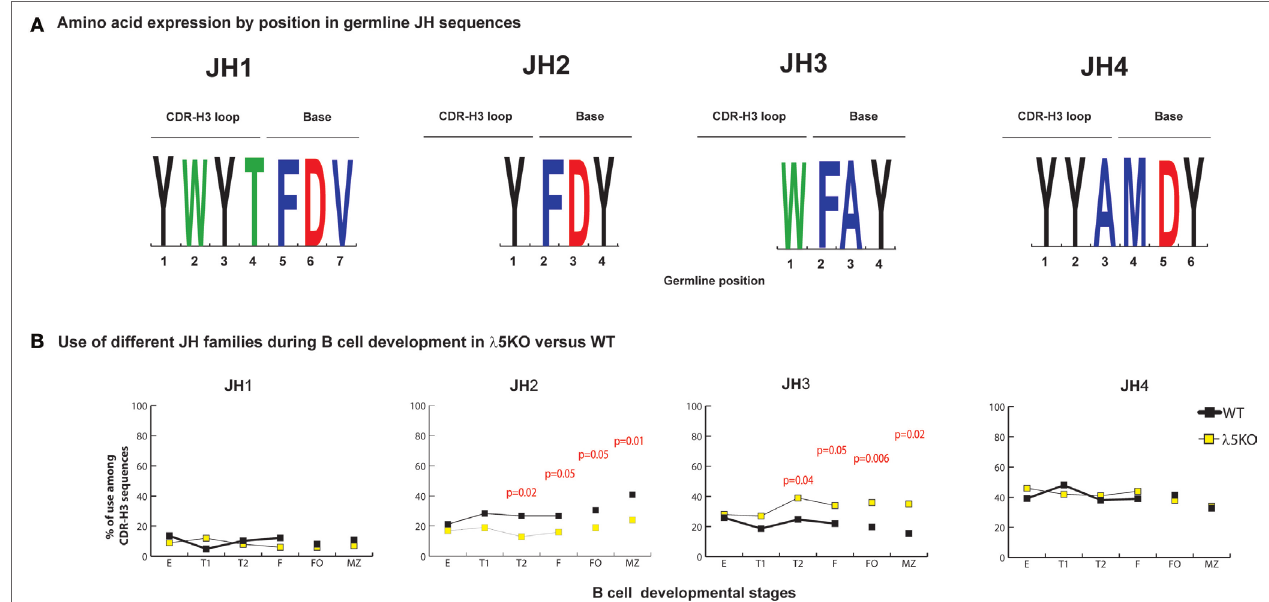
FigUre 3 | Differences in the use of J H in λ 5KO versus wild-type (WT). (a) The amino acid sequences of J H 1, J H 2, J H 3, and J H 4 that contribute to CDR-H3. The relative contributions of each J H sequence to the CDR-H3 loop and base are shown. The size of the single letter is proportional to its prevalence. (B) Representation of the use of different J H in selected bone marrow and splenic B cell subsets. The p -values for differences that achieved statistical significance ( p ≤ 0.05) are